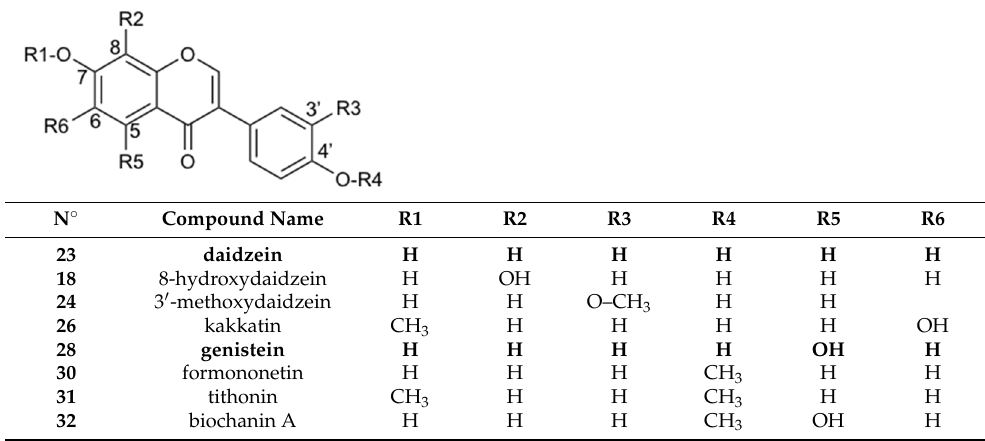
Table 2. Annotated isoflavone aglycones.